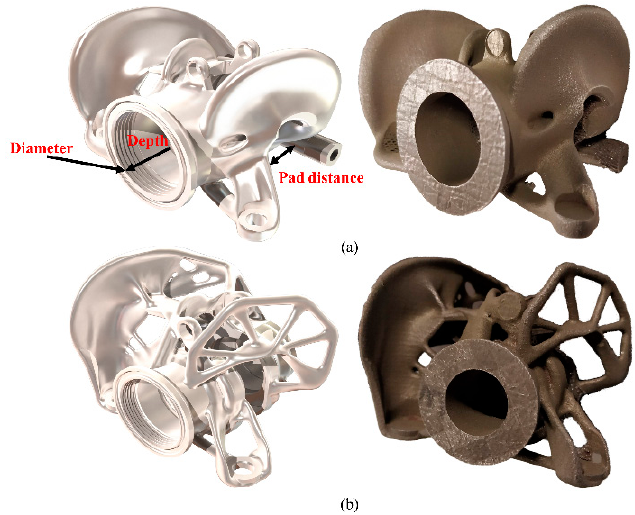
Figure 14. A geometry comparison between the CAD models and the 3D printed parts of the